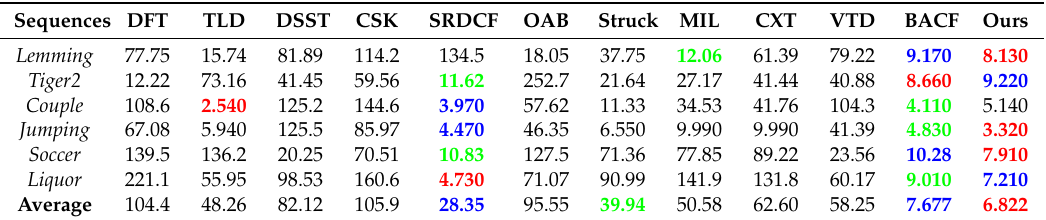
Table 1. Comparison of results in terms of average entry location errors (in pixels). In descending order, the best three estimates are marked in red, blue, and green